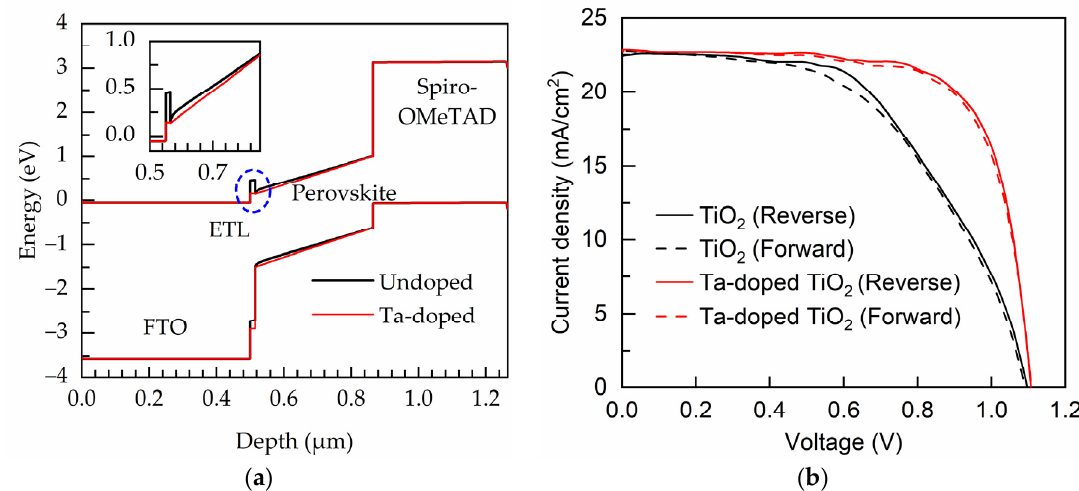
Figure 8. ( a ) Band bending of energy levels in PSCs. ( b ) J–V curves of the PSCs measured in reverse and forward directions. The inset shows the enlarged view at the ETL/perovskite interface. Table 3. Performance of PSCs measured in the reverse and forward directions.